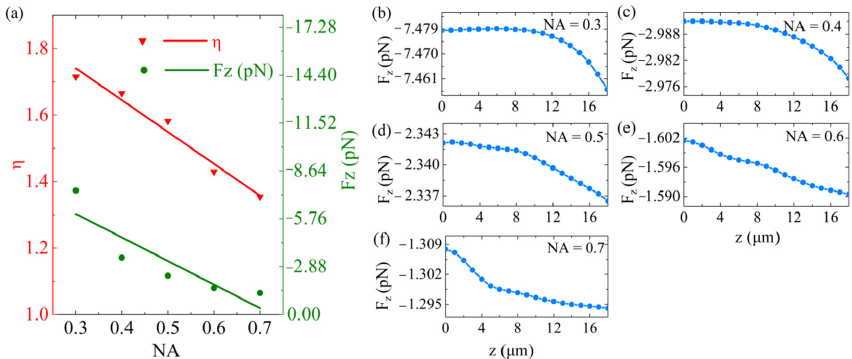
Figure 6. The OPF distributions within a NA range from 0.3 to 0.7. ( a ) Corresponding values for the OPF and the η , as a function of the NA. The metalens is located at the axial position z = 20 µ m. The OPF profiles on the z -direction ( x = y = 0) at the NA of ( b ) 0.3, ( c ) 0.4, ( d ) 0.5, ( e ) 0.6 and ( f ) 0.7, respectively. The OPF on the metalenses with different focal lengths f , including 10, 20, 30, 40, 50 and 60 μ m, respectively, was simulated, as shown in Figure 7. We consider that the appli- cation scenario of the designed metalens is space, and as such, did not consider the effect of gravity. During the simulation, the wavelength λ and the incident optical power P of the incident light, the width D and the unit cell parameters of the metalens remained con- stant. The NA of the metalens and the focal radius w 0 of the incident beam were changed to get different f . From Figure 7a, we find that the OPF and the η curves showed upward